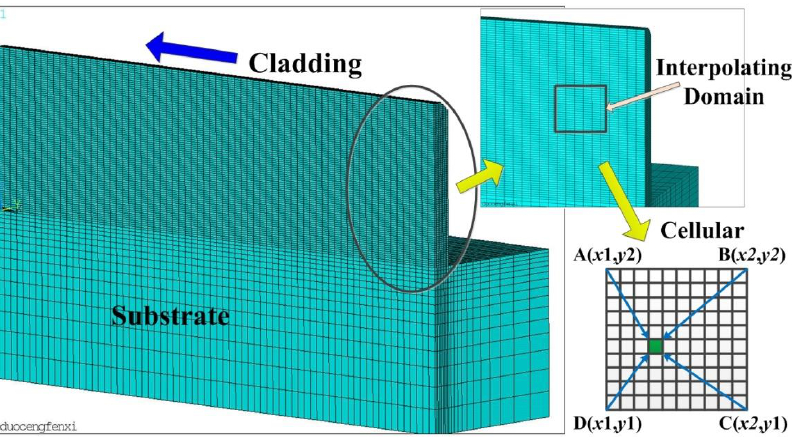
Figure 5. Macro-micro coupling model.